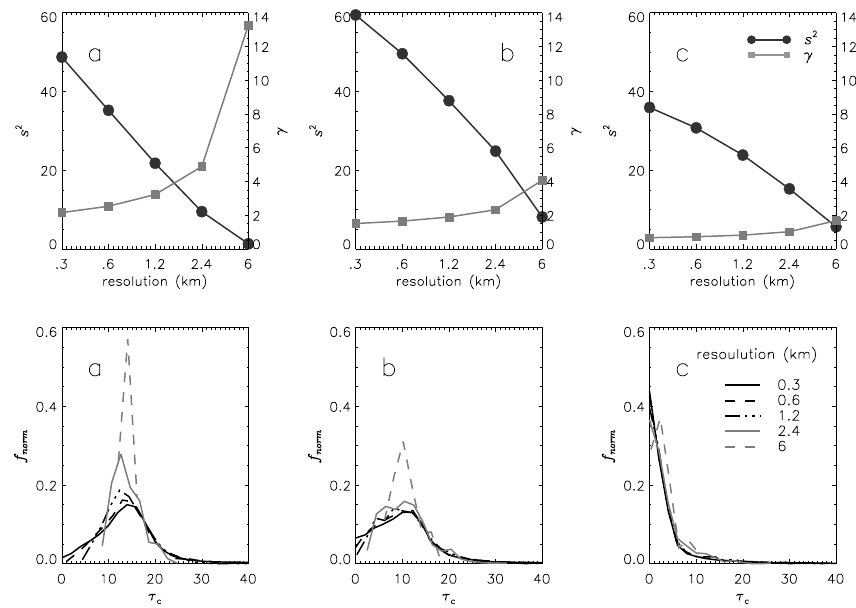
Fig. 6. Statistical parameters variance s 2 , homogeneity parameter γ , and normalized PDFs of τ c for the native resolution and aggregated scenes “a”, “b”, and “c” in Fig. 4.